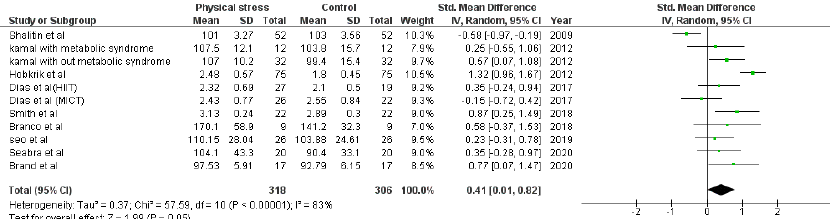
Figure 6. Forest plot showing the results for HDL.